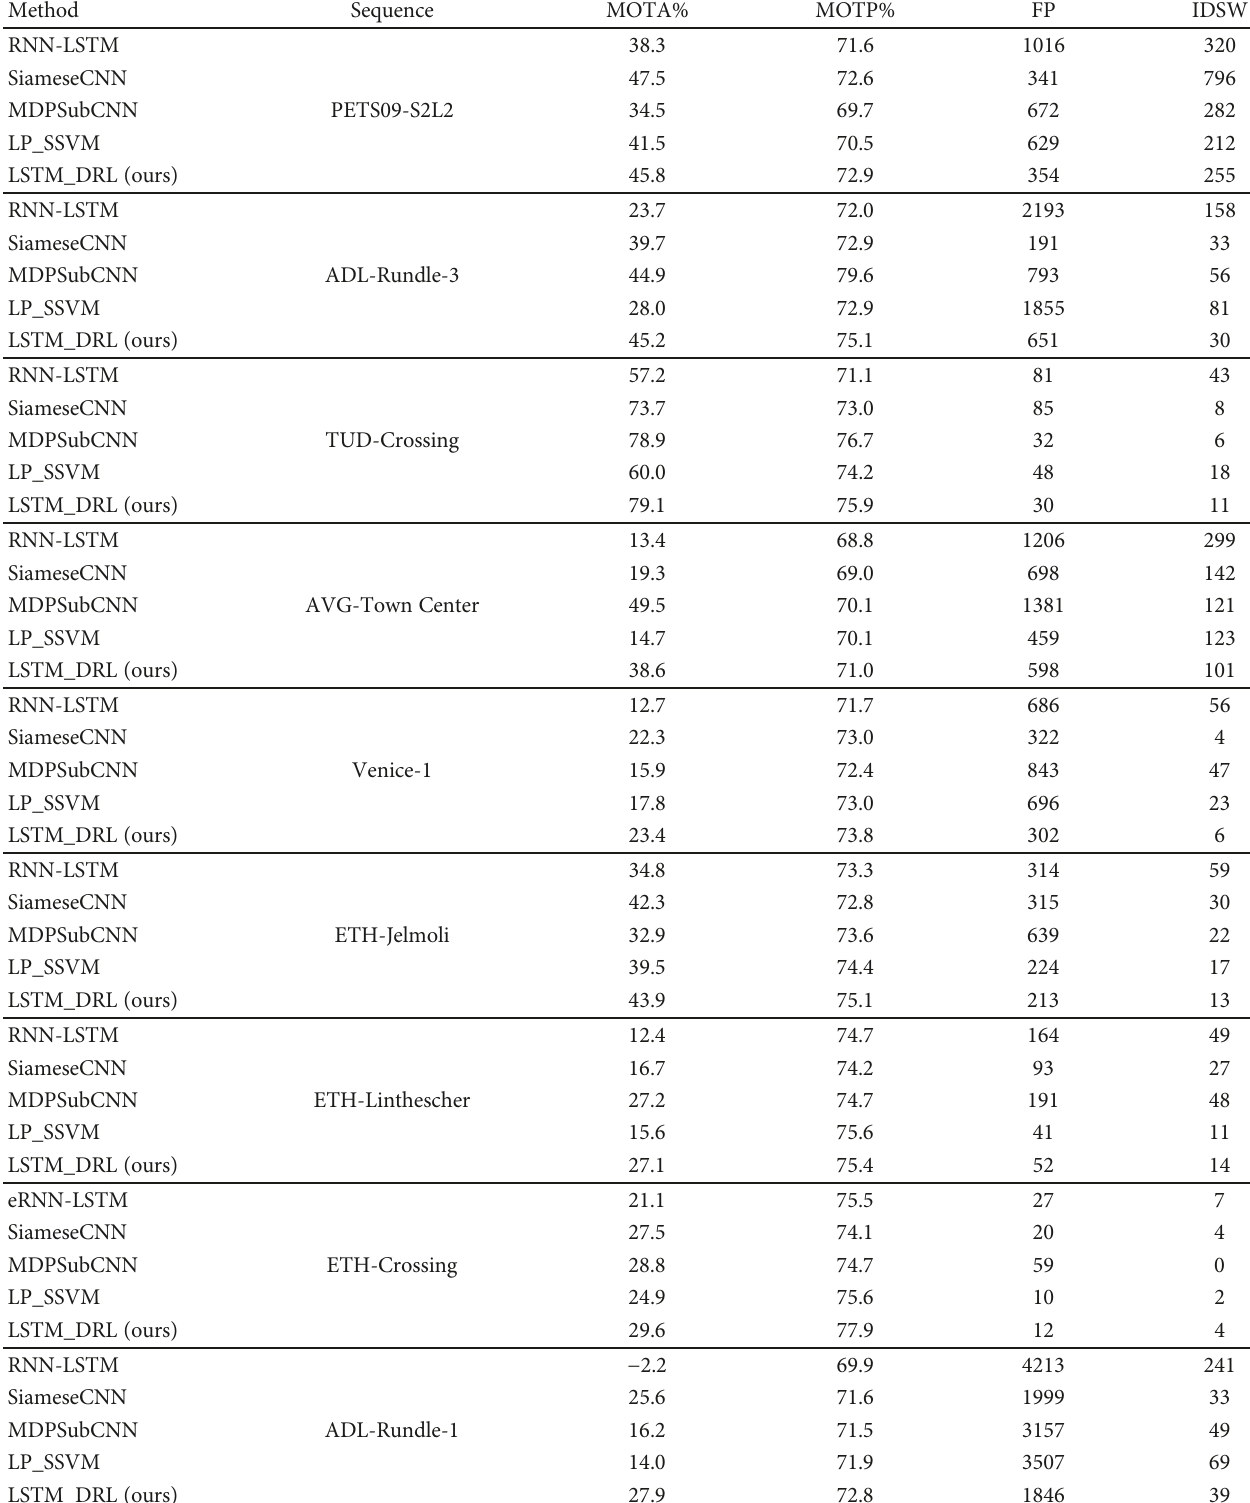
Table 1: The quantitative comparison results of our tracker with other state-of-the-art